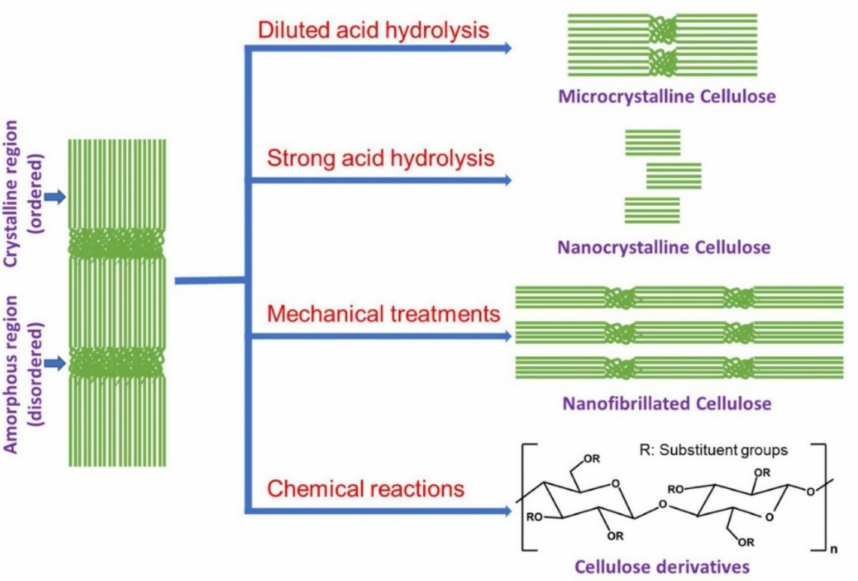
Figure 2. The development processes for several forms of cellulose. Reprinted with permission from Ref. [74]. Copyright © 2020 Elsevier Ltd. (License Number: